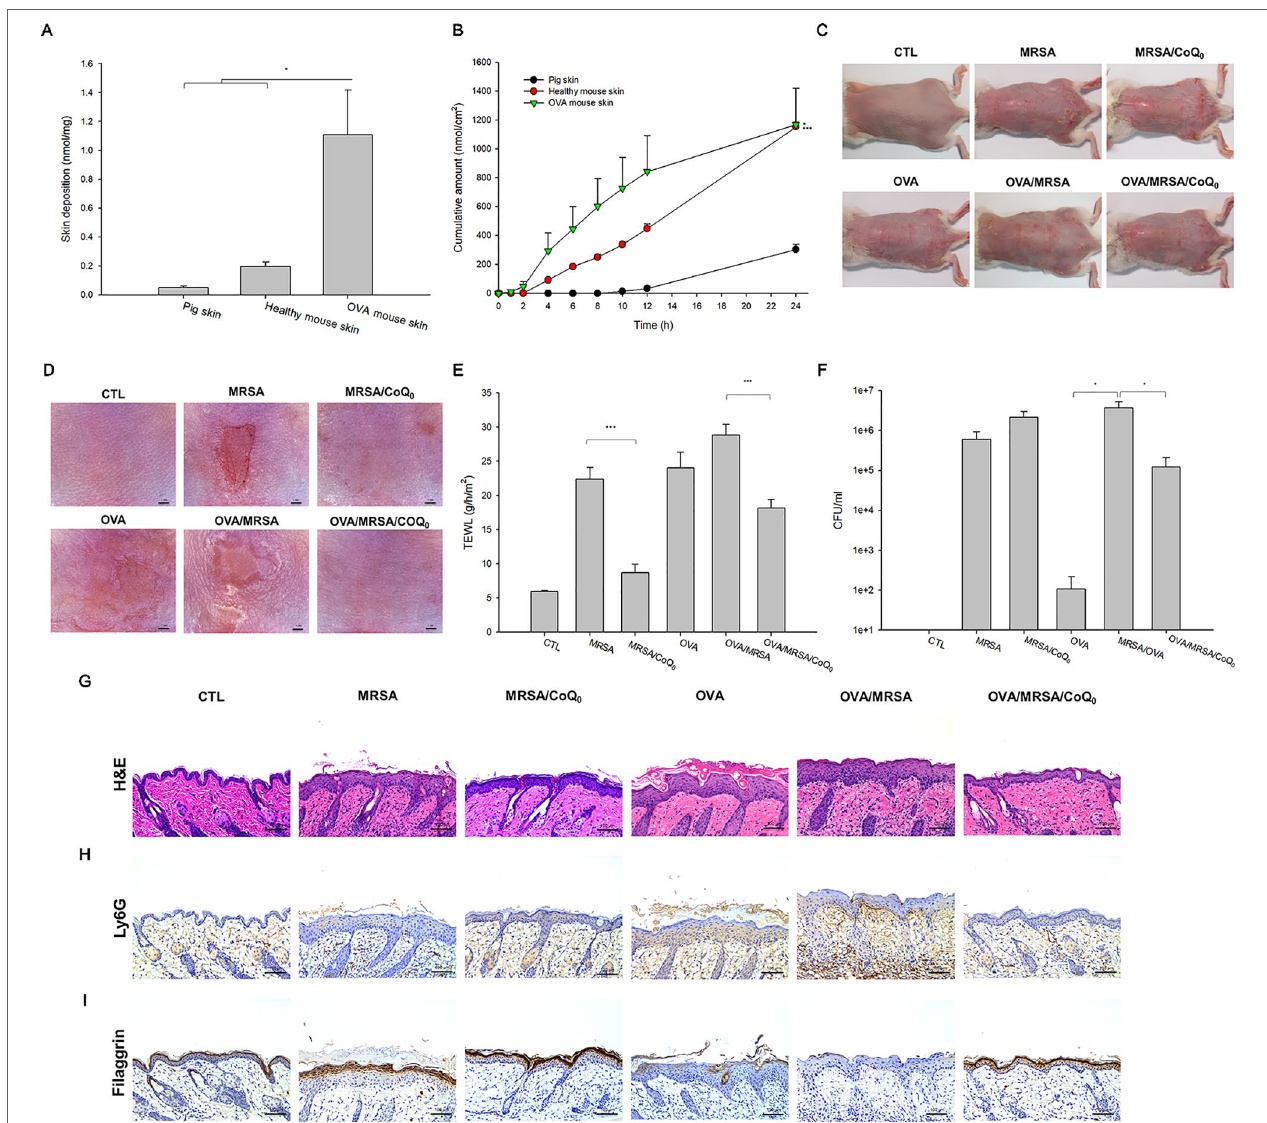
FIgURE 5 | In vitro skin absorption of CoQ 0 and in vivo topical application of CoQ 0 against MRSA-infected AD-like lesion. (A) In vitro skin deposition of CoQ 0 in Franz cell using pig, healthy mouse, and OVA-treated mouse skins. (B) In vitro skin permeation to receptor of CoQ 0 in Franz cell using pig, healthy mouse, and OVA- treated mouse skins. (C) The gross images of mouse back skin. (D) The close-up imaging by handheld digital microscopy. (E) TEWL of mice skin. (F) MRSA CFU of mice skin. (g) Skin sections represented by H&E staining. (h) Skin sections represented by Ly6G staining for observing neutrophils. (I) Skin sections represented by filaggrin staining for observing TJ distribution. Each value represents the mean ± SEM (n = 6). *** p < 0.001; * p < 0.05.